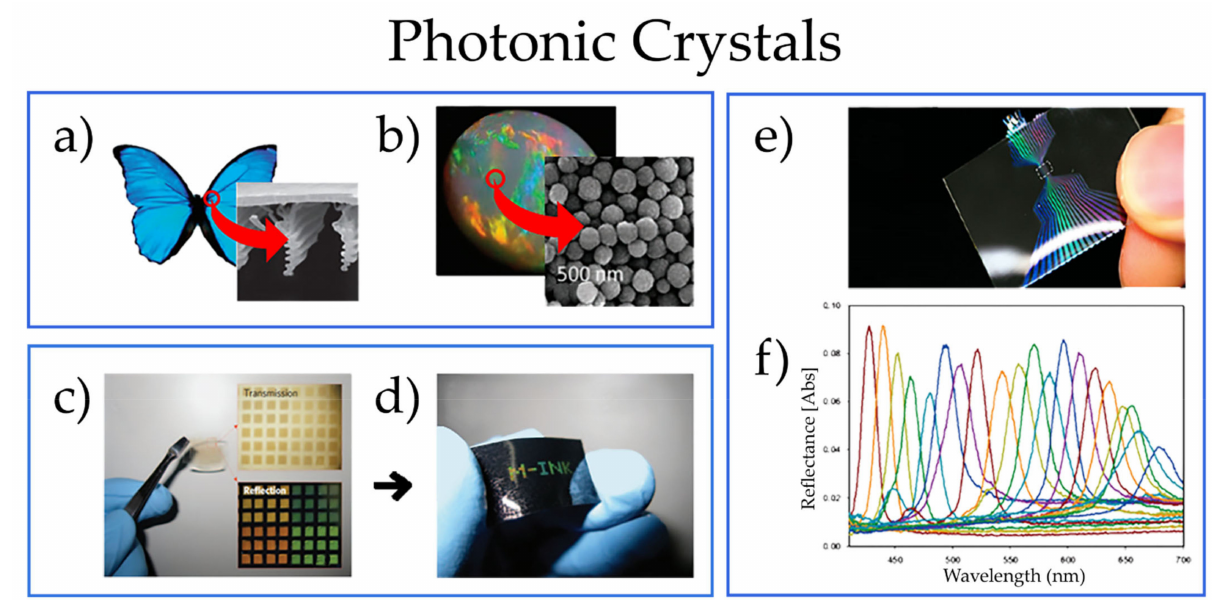
Figure 8. Natural photonic crystals (left): ( a ) photo showing the blue iridescence and SEM image of the 1D structure of the Morpho butterfly, ( b ) photo of an opal gemstone, and SEM image of the silica sphere structure within it. Adapted with permission from [121]. Copyright 2021 The Royal Society of Chemistry. Artificial fabricated photonic crystals deposited on flexible substrates made of semitransparent: ( c ) photonic crystal films and ( d ) photonic crystal films with anti-transmission black tape as the transferred substrate, which blocks backlight transmission [122], as well as ( e ) photo and ( f ) reflectance spectra of stripe-patterned composite photonic crystals with 20 different optical bandgaps. Adapted with permission from [123]. Copyright 2021 John Wiley and